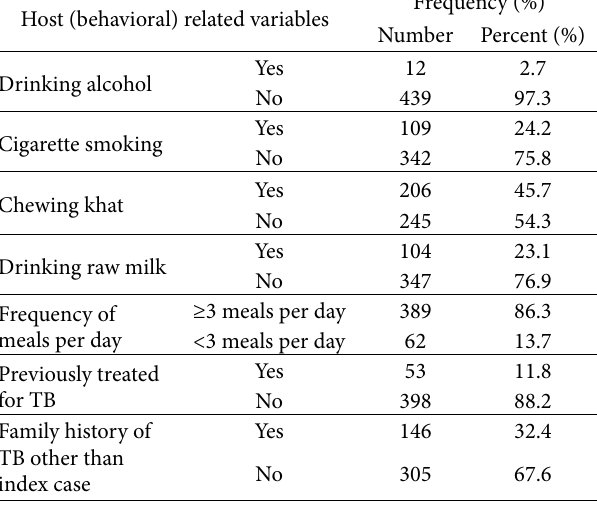
Table 3: Behavioral related characteristics of adult household contacts of smear positive PTB patients in Haramaya district, Eastern Ethiopia, 2019 ( 푛 = 451